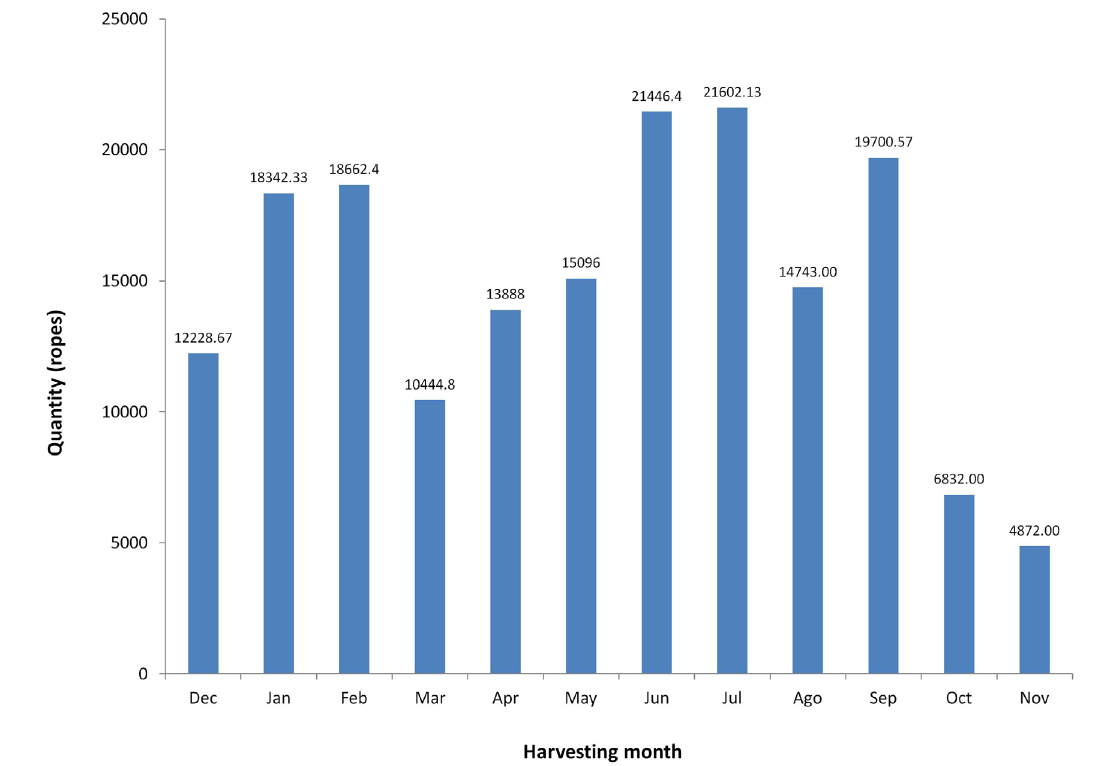
Figure 7. Quantity (ropes) of Ucides cordatus recorded at daytime landing at Tatus Harbor, Ilha Grande, Piauí,